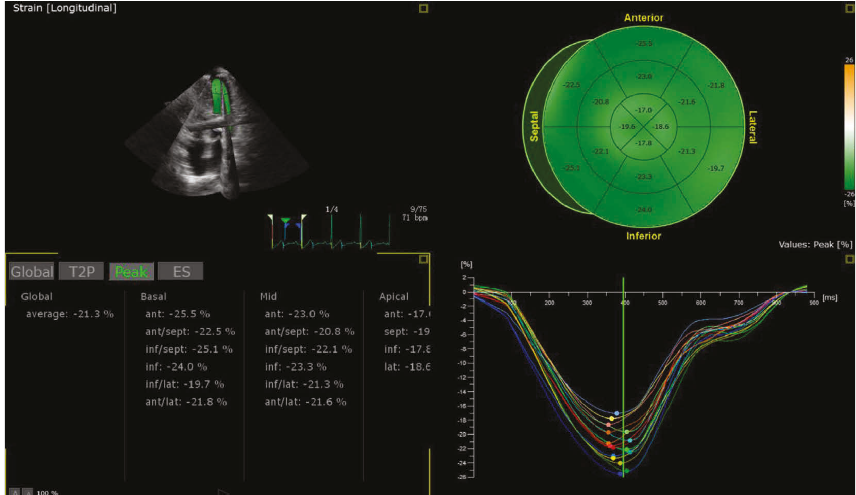
Figure 5: Gene carrier’s illustration of the bull